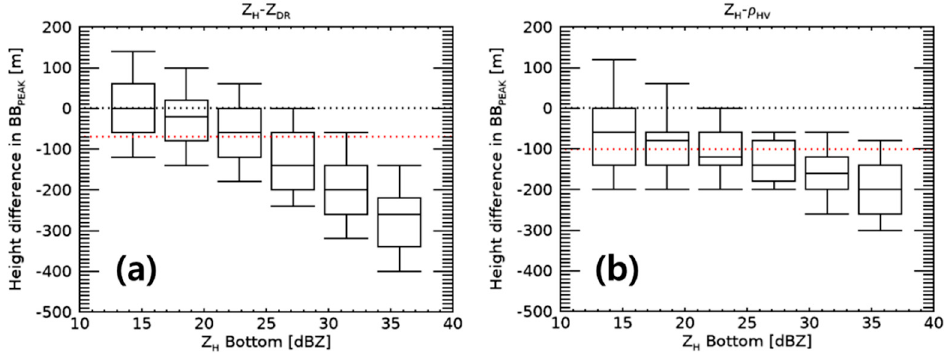
Figure 6. Box plots of the mean differences between H(Z H Peak) and H(Z DR Peak) ( a ), and between H(Z H Peak) and H( ρ HV Peak) ( b ) as a function of Z H Bottom. The black (red) dotted line indicates no difference (the mean height difference).